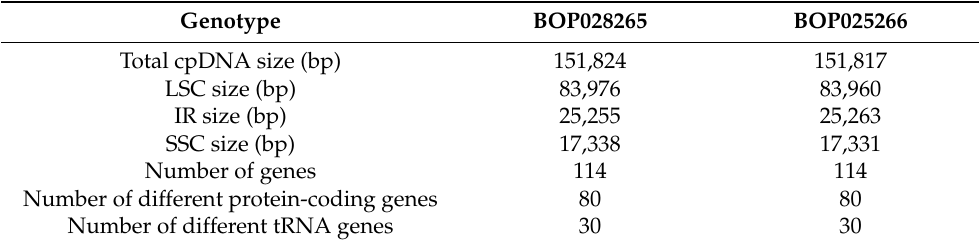
Table 1. Summary of the characteristics of Scutellaria baicalensis chloroplast